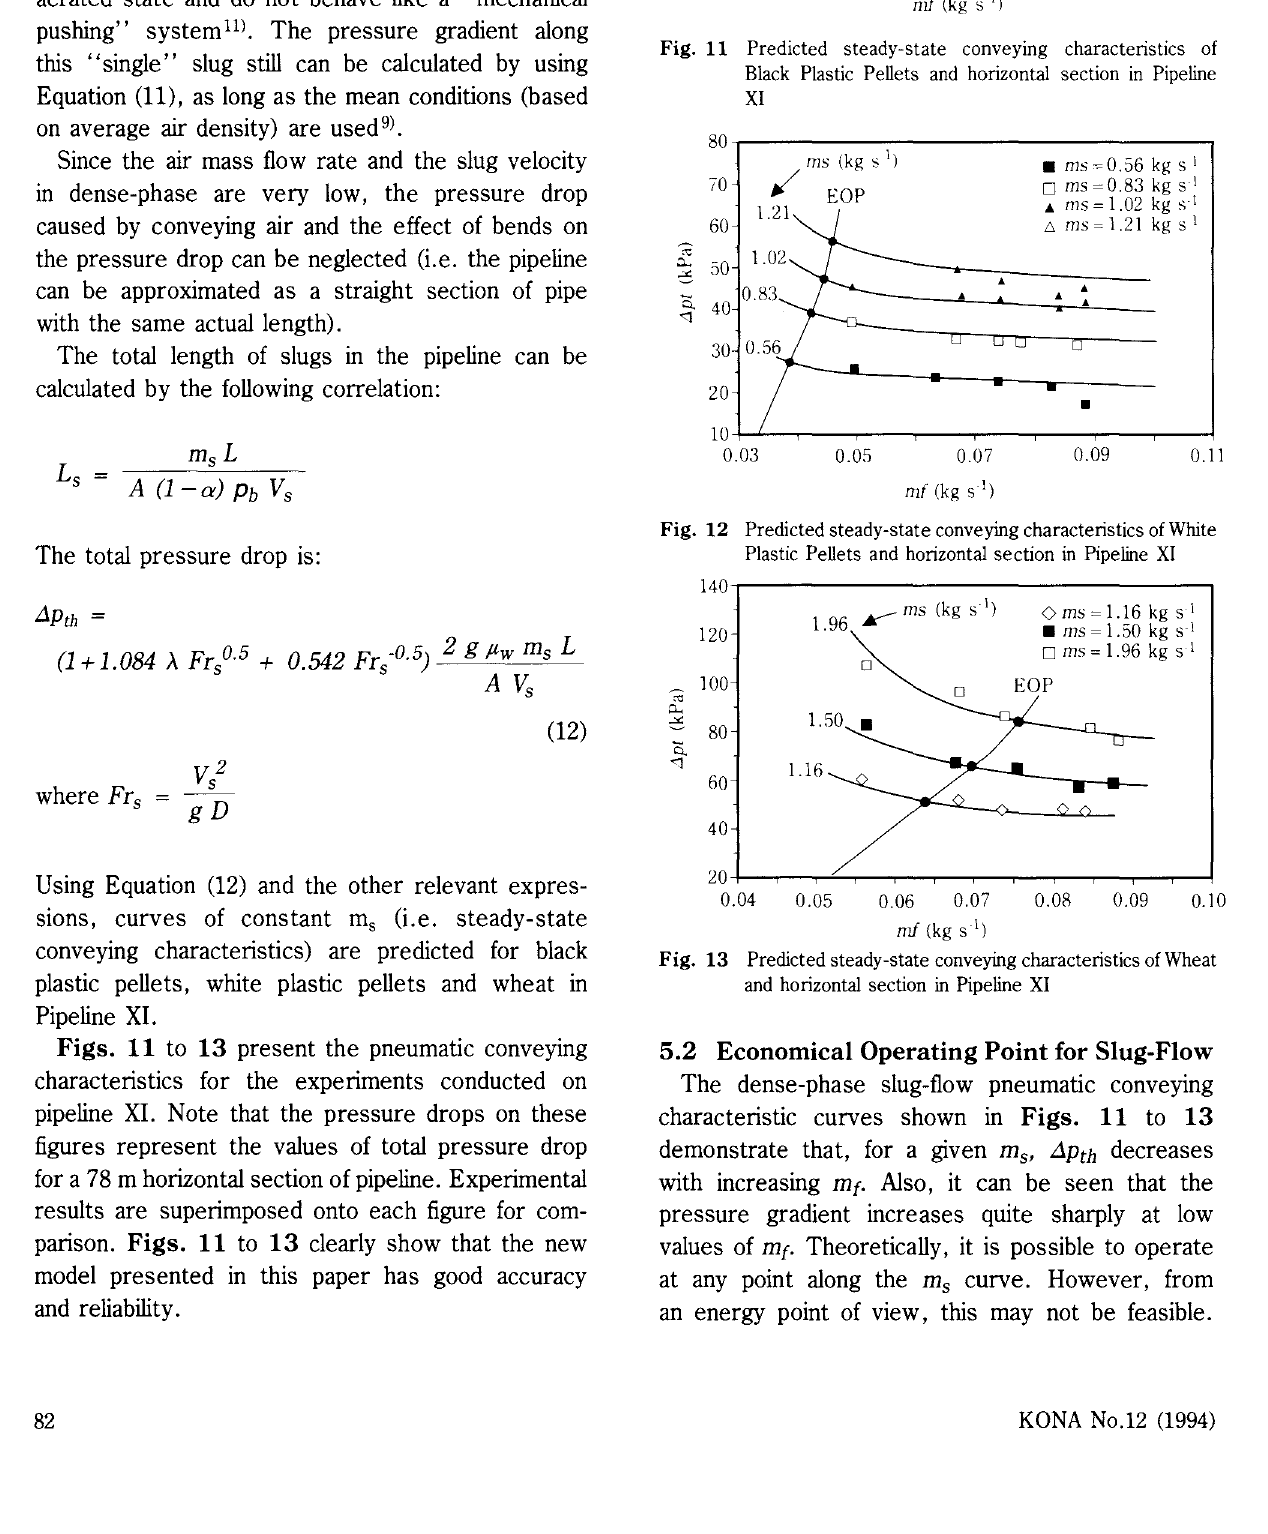
Fig. 11 Predicted steady-state conveying characteristics of Black Plastic Pellets and horizontal section in Pipeline